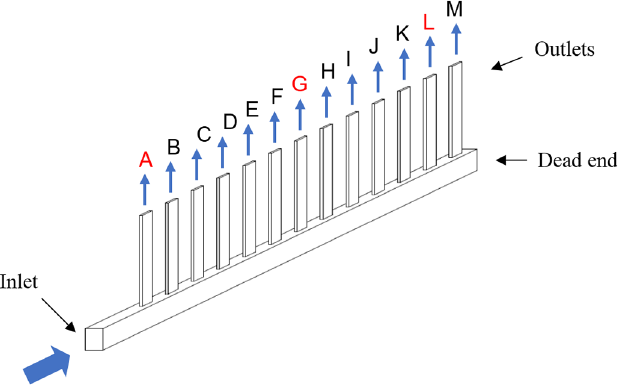
Fig. 3. Schematics of a branch, zones I and II are de